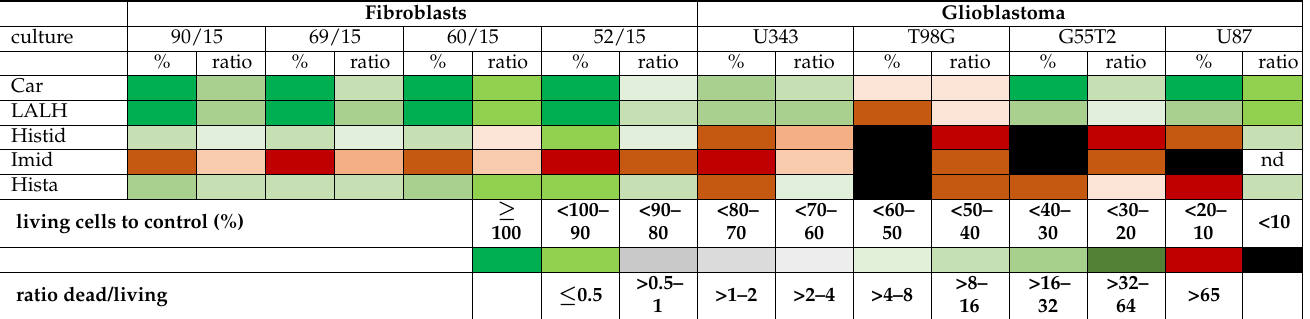
Table 2. Comparison of living cells and the ratio between dead and living cells in fibroblasts and glioblastoma cell cultures under the influence of different